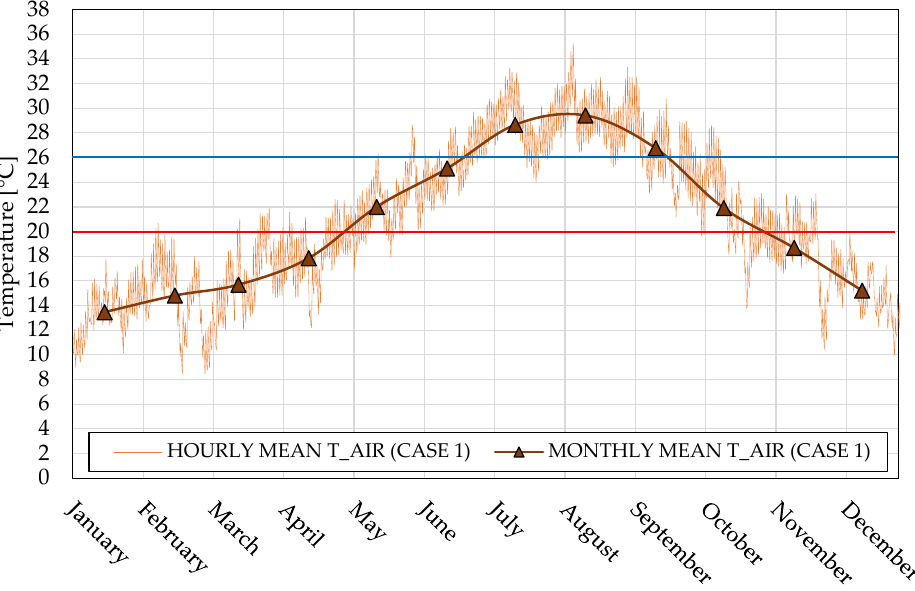
Figure 8. Hourly average and the monthly average indoor air temperature in the THU without PCM (CASE 1).